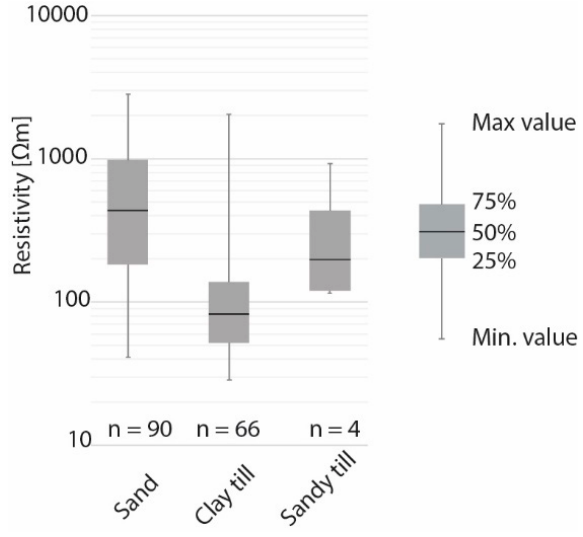
Figure 8. Box plot showing the resistivities within the Provstlund site. N represents the number of measurements for each soil type. Table 2. Boreholes, Measured Percolation Rates, Nearest Resistivity and Lithology for the 18 Drillings at the Provstlund